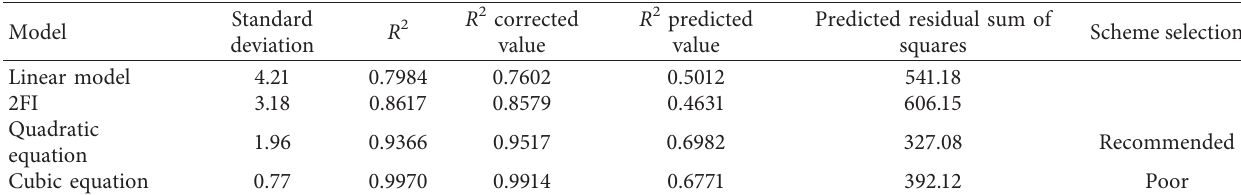
Table 3: Comprehensive evaluation of R 2 of comprehensive combustion characteristic index.